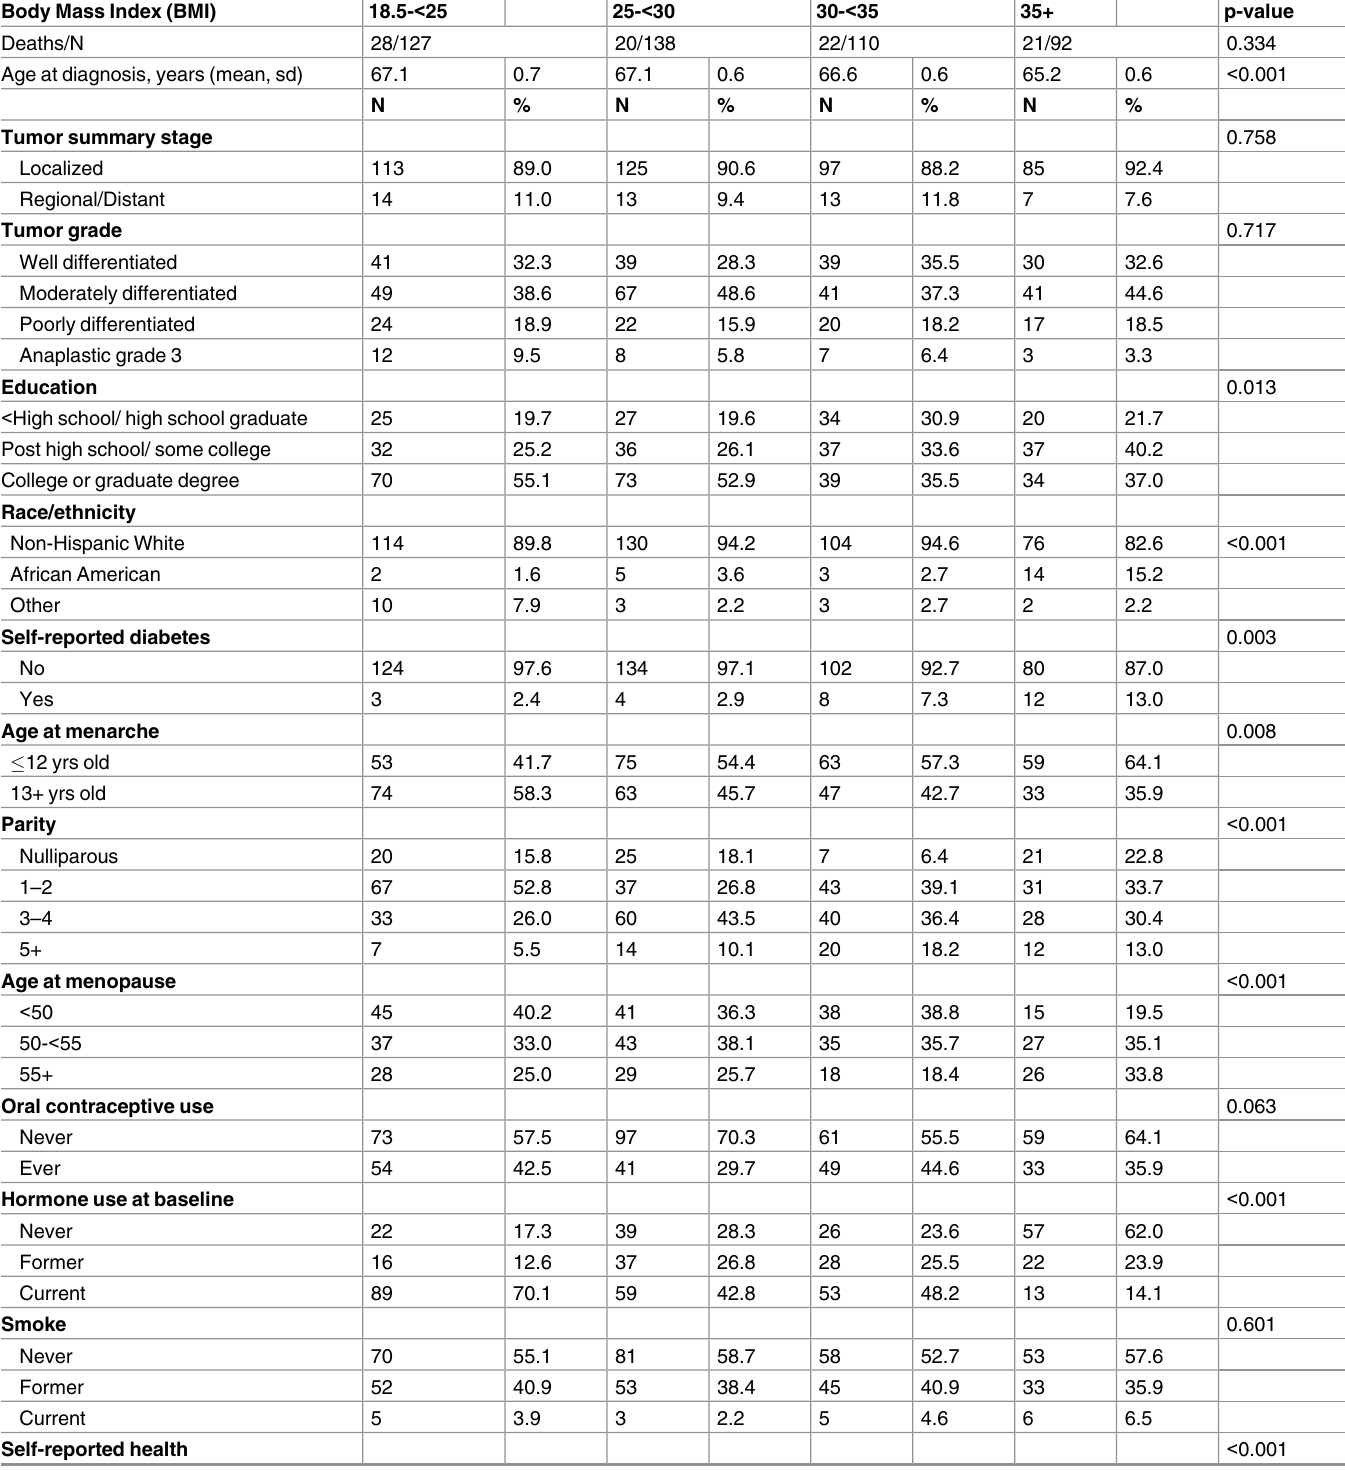
Table 1. Baseline characteristics of the women diagnosed with endometrial cancer in the Women’s Health Initiative study populations by level of baseline body mass index (BMI) (kg/m 2 ) (N =